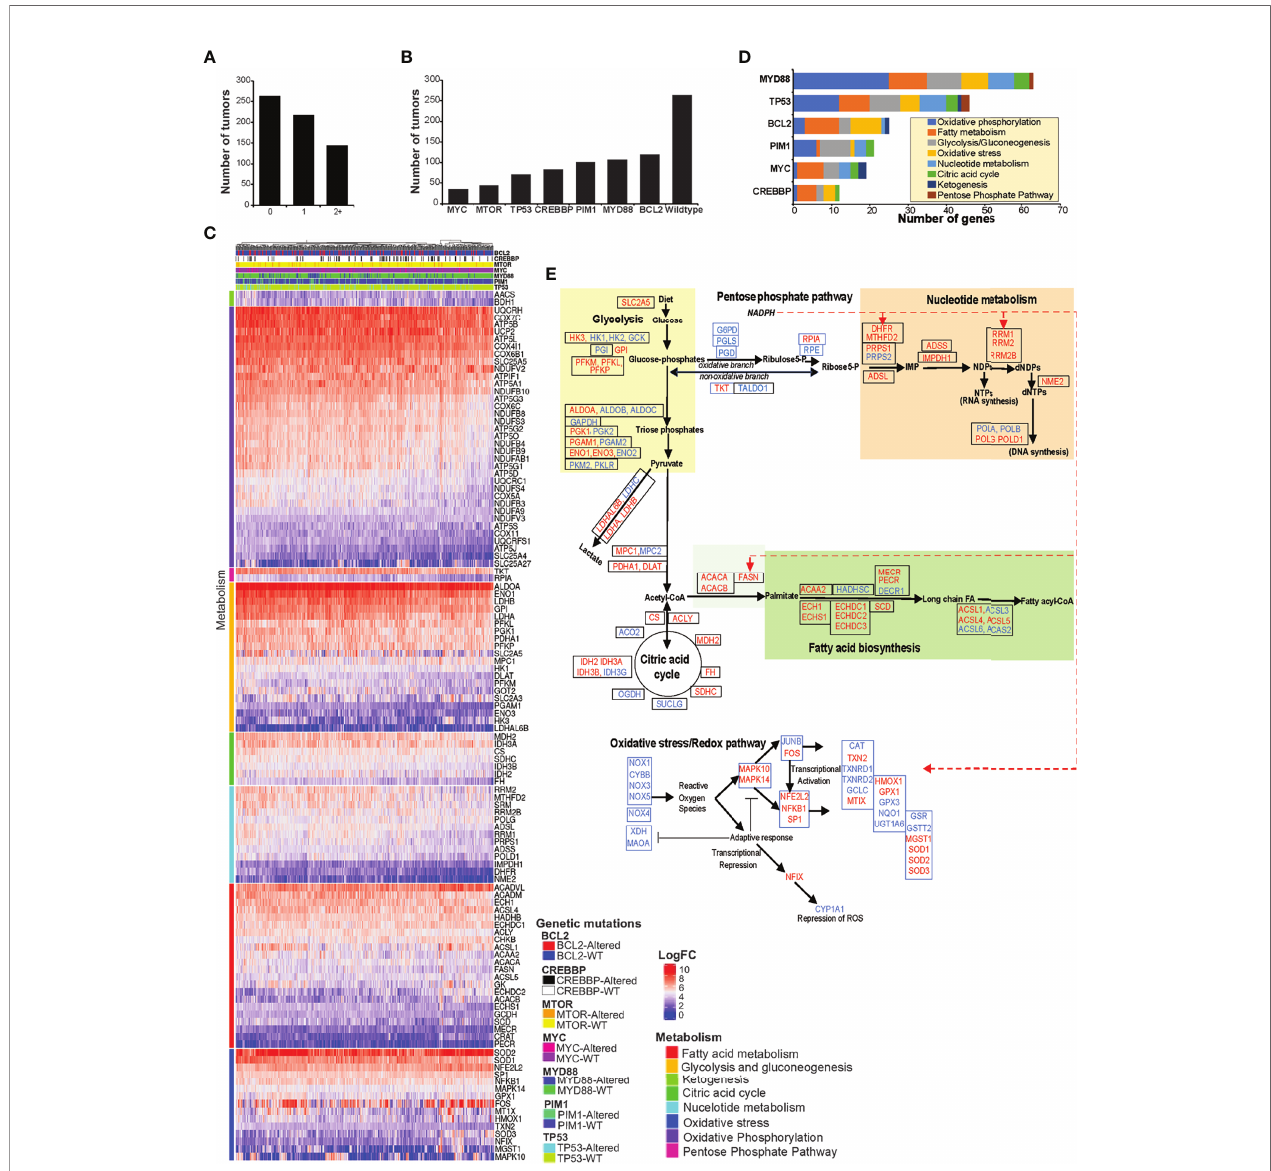
FIGURE 7 | DLBCL metabolic transcriptome. (A, B) Bar graphs represent the proportion and distribution by number of tumors, consisting of wild-type, single, or multiple mutations in MYC, MTOR, TP53, CREBBP, PIM1, MYD88, and TP53. (C) Heat map representing the differential expression of metabolic genes, signi fi cant by single-gene mutation with P < 0.005, comparing tumors that consist of wild-type or mutant MYC, MTOR, TP53, CREBBP, PIM1, MYD88, and TP53 genes ( n = 624). (D) Bar graph representing the number of genes overexpressed by metabolic pathways and distribution by genetic mutations. (E) Flow chart representing the mapping of differentially expressed genes corresponding to glucose, pentose phosphate pathway, lipid, and redox metabolic pathways. The upregulated genes are indicated in red color, and the unaffected genes are indicated in blue color. Dashed red lines indicate NADPH-related